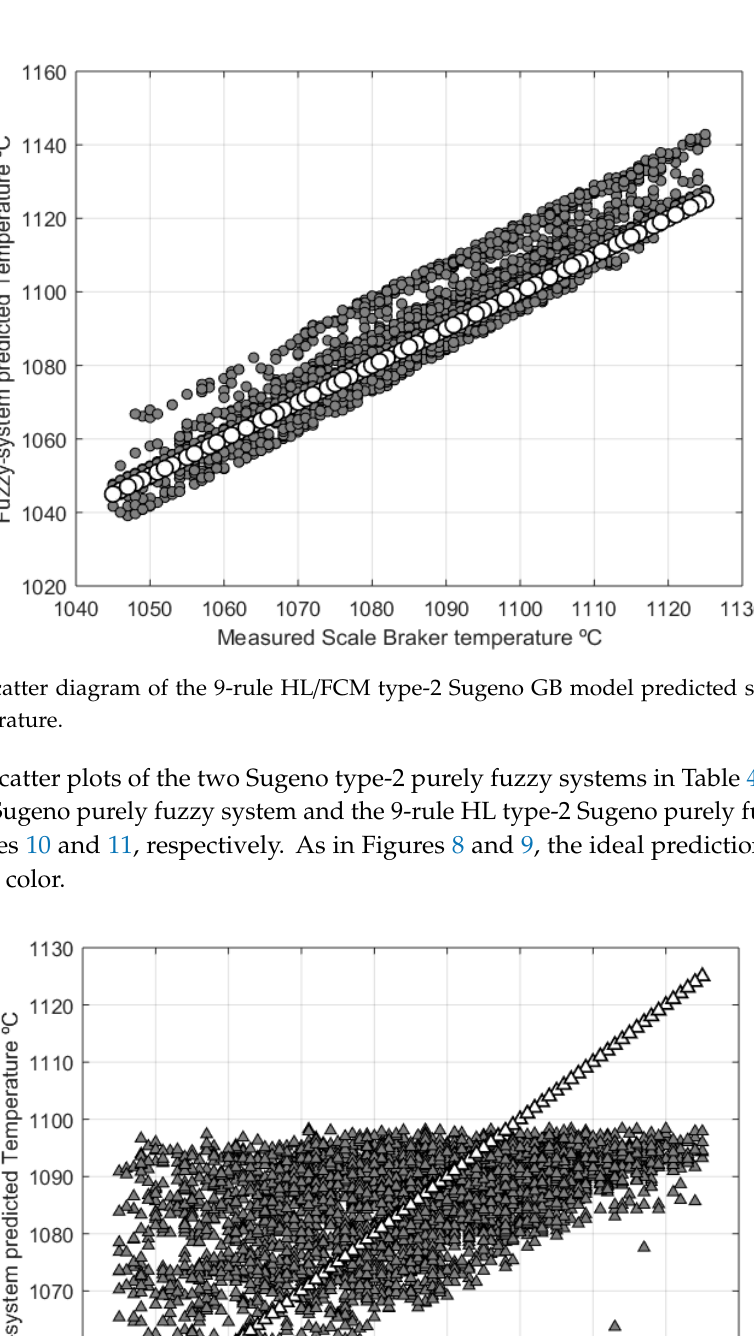
Figure 8. Scatter diagram of the 25-rule HL/FCM type-2 Sugeno GB model predicted scale breaker entry temperature.